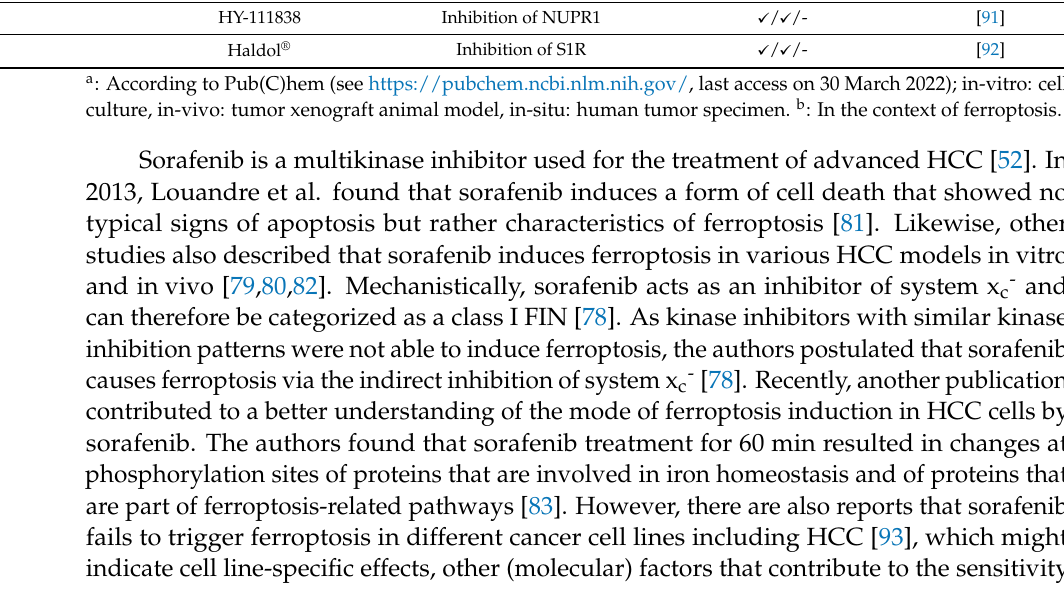
Table 1. Ferroptosis inducer and their major mode of action in HCC.